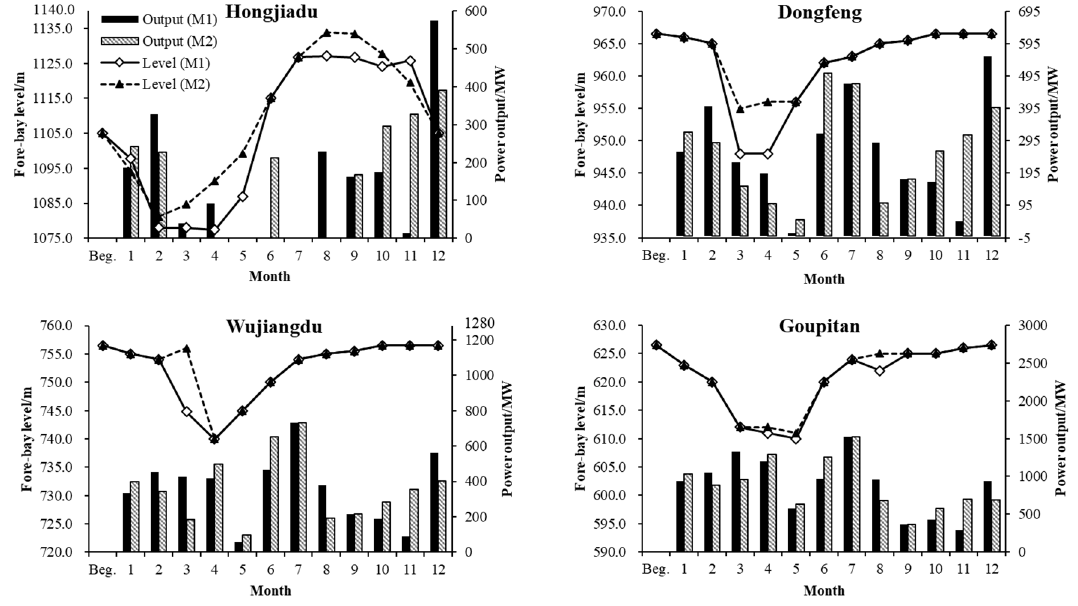
Figure 6. The optimization process of regulating reservoirs (M1 represents the proposed model, M2 represents the conventional model).